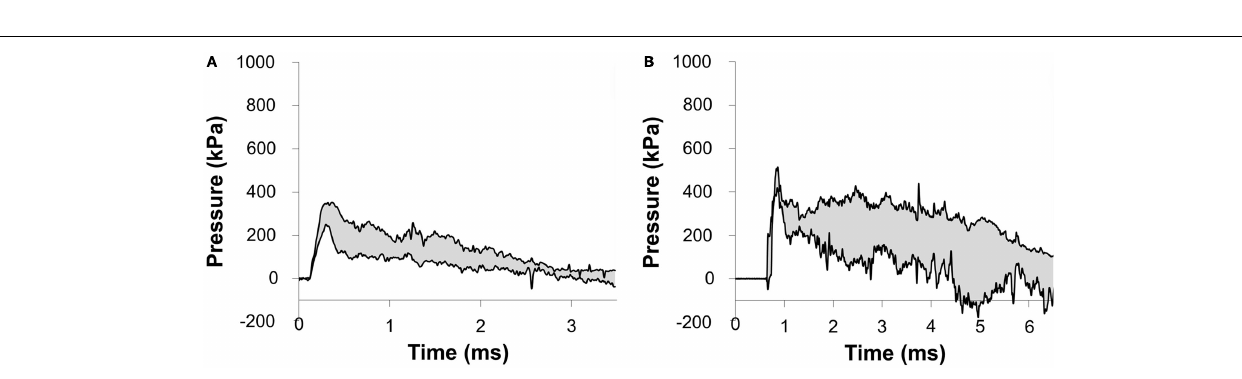
pair t -test, p = 0.0001). The 500-kPa, 3.1 ms tests were not instru-